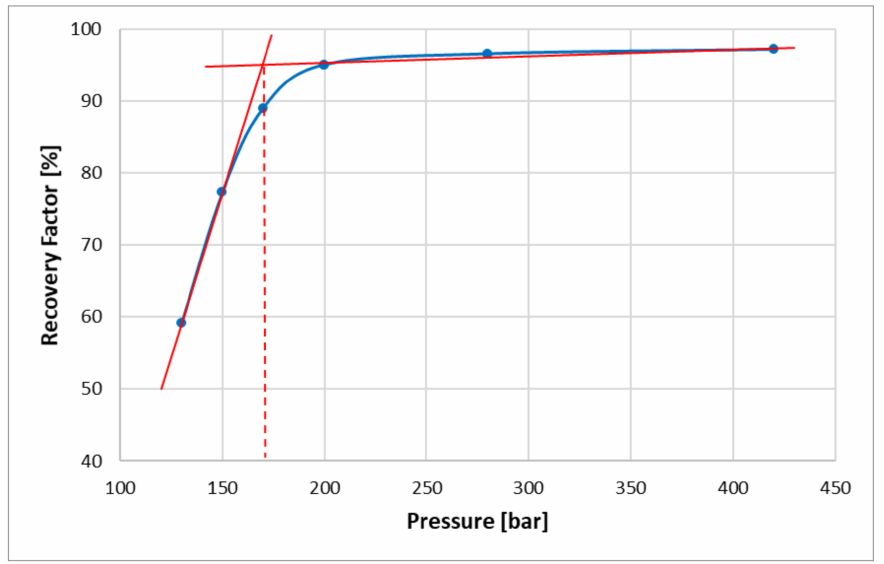
Figure 9. Slim tube recovery factors for H 2 S plotted against pressure—MMP